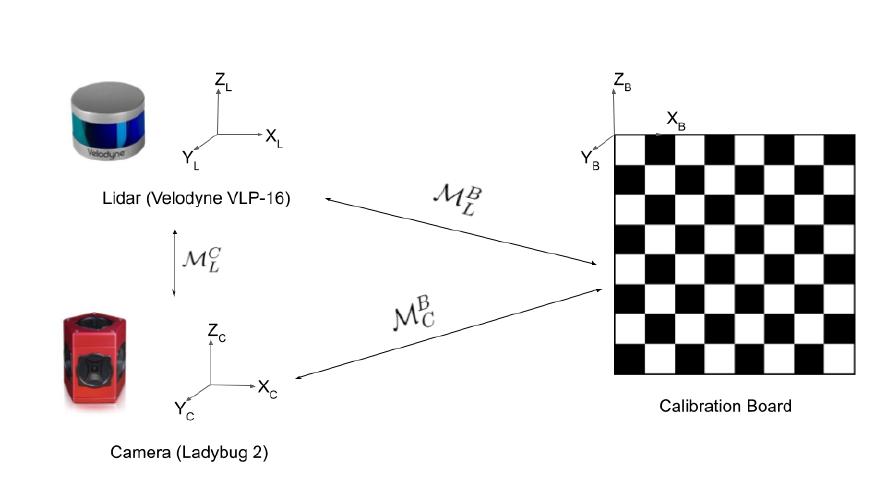
Figure 5. Principle of extrinsic calibration. The objective is to find the rigid transform M C LiDAR and the camera. It is currently mostly done manually using a calibration target like a 2D or 3D chessboard or pattern and by detecting this pattern for each modality ( M B